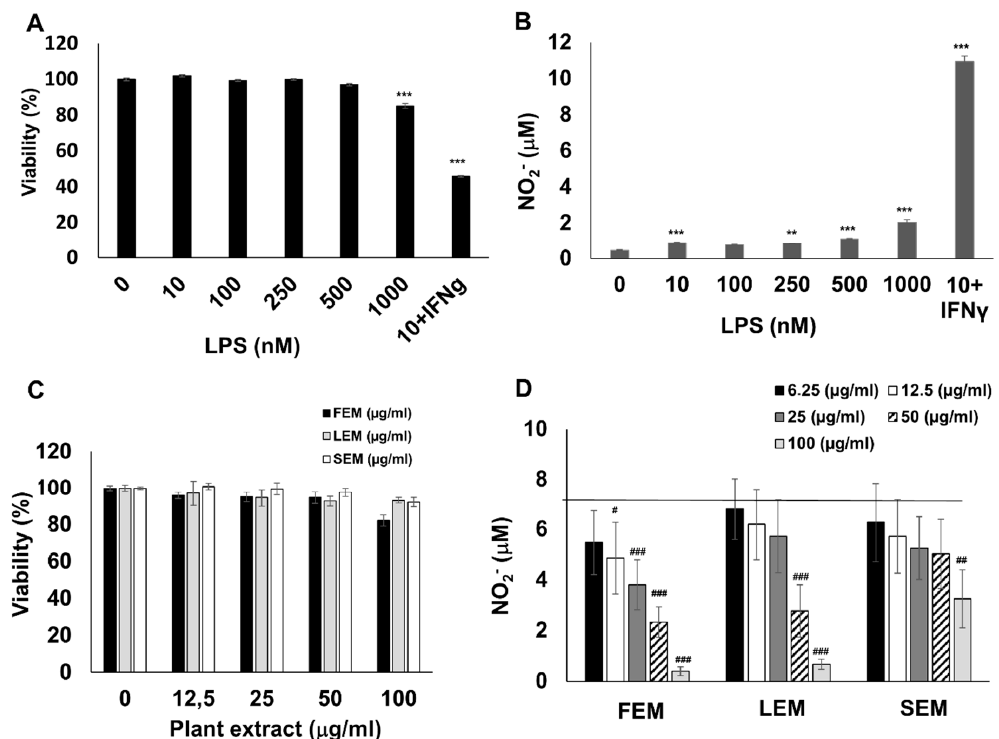
Figure 1. S. acmella extracts are non-toxic and suppress NO production in LPS + IFN γ -treated RAW264.7 macrophages. RAW cells were stimulated with the indicated concentrations of LPS with or without 10 ng/mL IFN γ . ( A ) Cell viability was measured with MTT assay and ( B ) NO release was assessed as NO 2- levels in the cell culture medium. ( C ) RAW264.7 cells were treated with (up to 100 µg extracted substance per ml of culture medium) the methanol extracts of floral (FEM), leaf (LEM) or stem (SEM) tissue from S. acmella and viability was measured with MTT assay. The extracts did not affect cell viability. ( D ) FEM, LEM, and SEM significantly and concentration-dependently decreased NO production. The solid horizontal line marks NO release from 10 ng/mL LPS + 10 ng/mL IFN γ -treated cells in the presence of no plant extract. # Hashmarks indicate significant (### p < 0.001) changes induced by IFN γ + LPS in viability ( A ) or NO production ( B ) as well as significant (# p < 0.05, ## p < 0.01, ### p < 0.001) inhibition of IFN γ + LPS-induced NO production by the plant extracts ( D